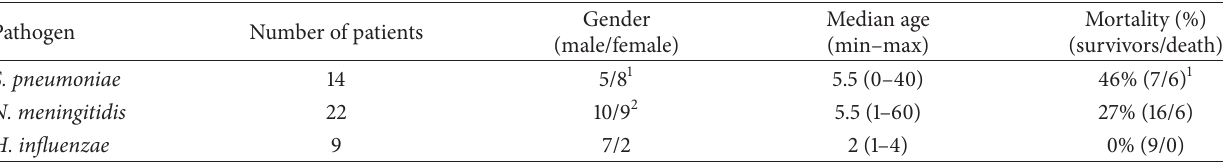
Table 1: Patient groups characteristics.